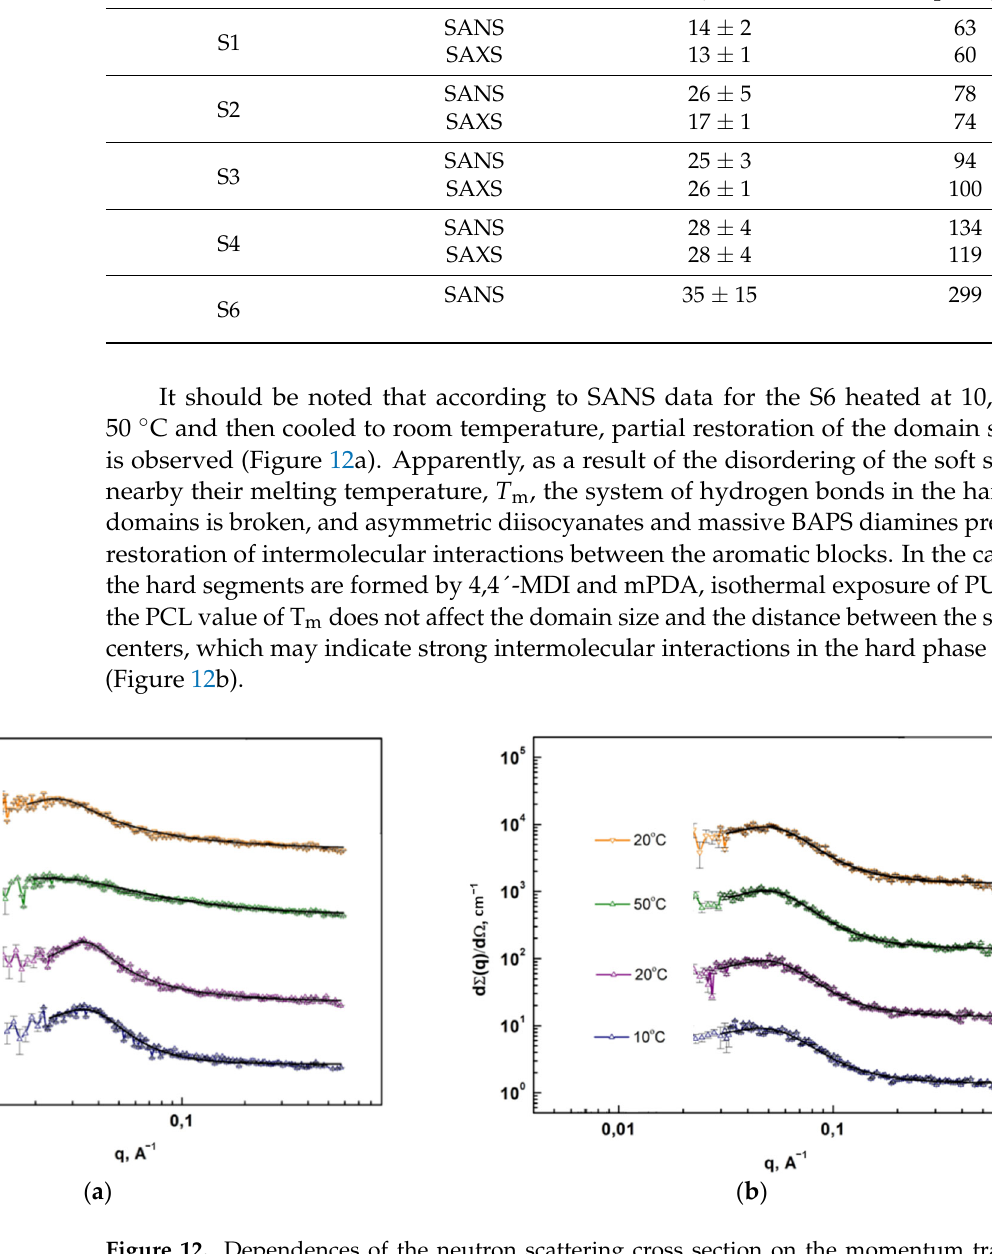
Figure 12. Dependences of the neutron scattering cross section on the momentum transfer for different stages during the temperature experiment for S6 ( a ) and S4 ( b ). The solid black lines are approximation according to Eq. 4.